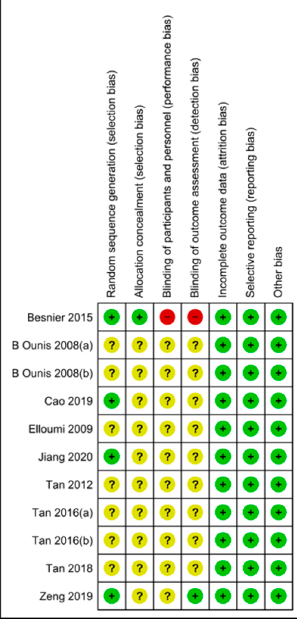
Figure 2. Risk of bias summary. Authors’ judgements about each risk of bias item for every included study. Green means low risk of bias; yellow, unclear risk of bias and red, high risk of bias.